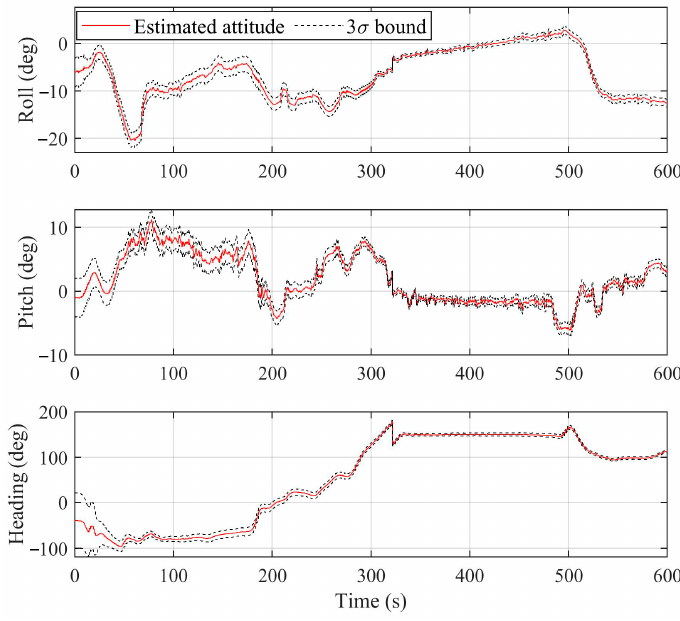
Figure 18. Estimated attitude of the aircraft with ±3𝜎 bound.